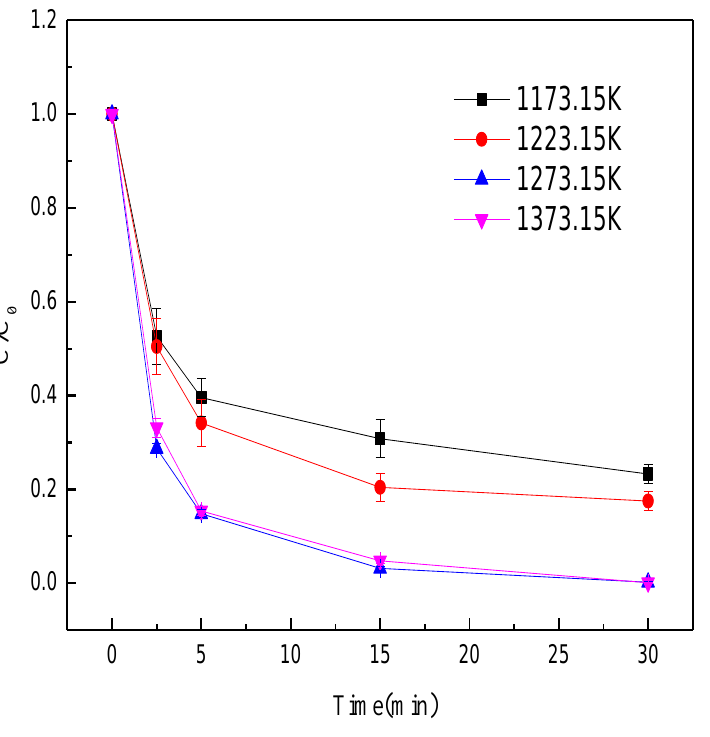
Figure 2. Effects of roasting temperature on the decolorization efficiency of methyl orange. To investigate the effects of coal amount on methyl orange decolorization, we conducted batch experiments with different mass ratios of Fe/C (4:1, 6:1, 10:1) while keeping other parameters constant. Clearly, the methyl orange decolorization efficiency first increased and then declined with the rise of mass ratio of Fe/C (Figure 3). As the mass ratio of Fe/C rose from 4:1 to 6:1, the methyl orange decolorization rate within 15 min increased from 96.84% to 99.90%. When the mass ratio of Fe/C further increased to 10:1, the decolorization efficiency dropped to 98.85%. The possible reason was that when the mass ratio of Fe/C was insufficient, the iron minerals cannot be fully reduced to ZVI. However, when the mass ratio of Fe/C was excessive, the coal was reserved in MEM, which decreased the decolorization rate of methyl orange. Hence, in the subsequent experiments, the optimal mass ratio of Fe/C was set at 6:1. Then, the effects of calcination time (10, 15, 20, 40 min) on the methyl orange de- colorization were evaluated at 1000 ◦ C and with the Fe/C mass ratio of 6:1 while other conditions were unchanged. The decolorization efficiency increased with the prolonging of calcination time from 10 to 20 min (Figure 4). When the calcination time exceeded 20 min, the decolorization efficiency did not improve. The possible reason is that appropriate pro- longing of calcination time is favorable for the production of ZVI. After the iron minerals were fully reduced, prolonging the calcination time did not increase the ZVI content, but led to ZVI aggregation instead, which weakened the decolorization efficiency of methyl orange. Thus, the optimal calcination time was set at 20